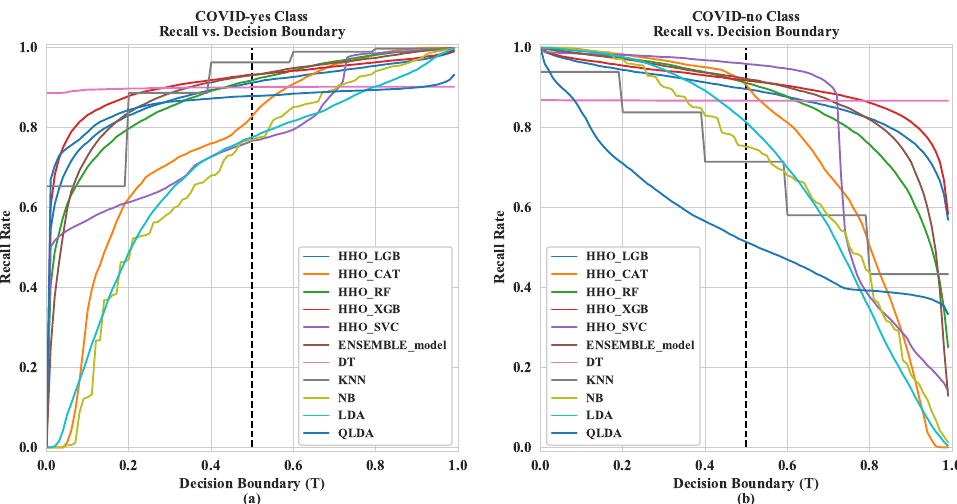
Figure 4. Visualization of recall vs. decision boundary for ( a ) “COVID-yes” class and ( b ) “COVID-no”